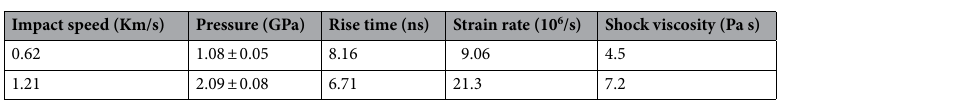
Table 1. Estimated strain rate and shock viscosity.